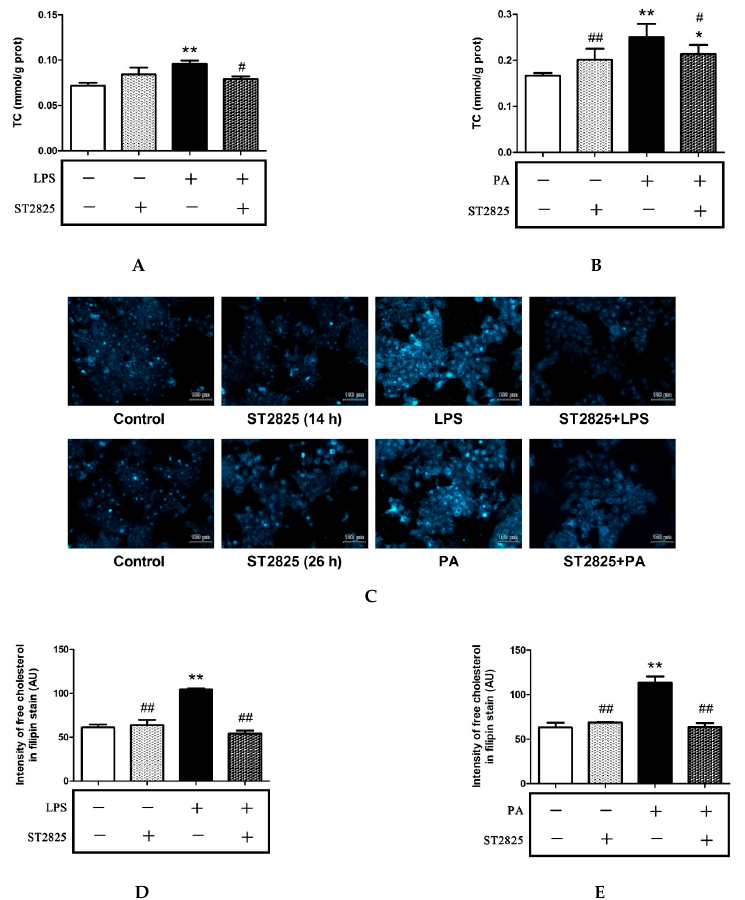
Figure 5. MyD88 inhibitor ST2825 reduced the cholesterol content in LPS- or PA-treated HepG2 cells. HepG2 cells were pre-treated with 20 μ mol/L ST2825 for 2 h and then stimulated with LPS (1 μ g/mL) for 12 h or with PA (200 μ mol/L) for 24 h. Intracellular TC was determined with a commercial kit ( A , B ). Intracellular free cholesterol was visualized using filipin staining ( C ) and quantified with ImageJ and SPSS20.0 software ( D , E ). The results are presented as means ± SD of three independent experiments; *: p < 0.05 vs. control; **: p < 0.01 vs. control; #: p < 0.05 vs. LPS or PA alone; ##: p < 0.01 vs. LPS or PA alone.